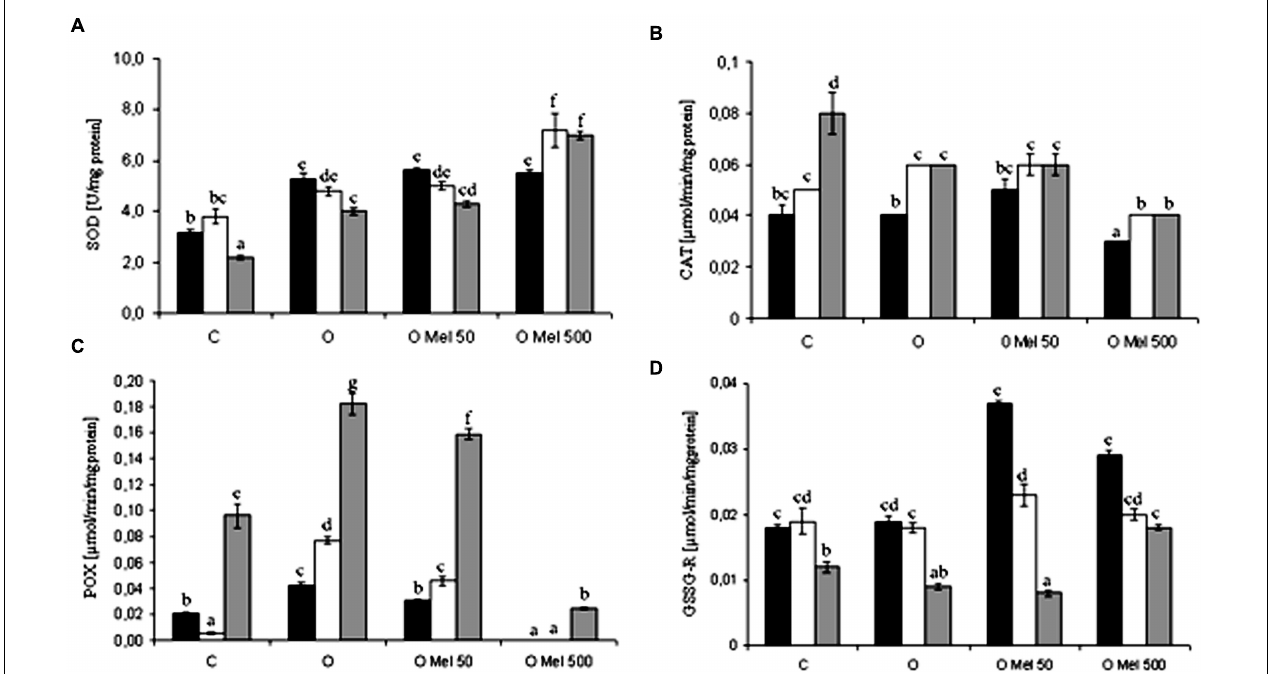
FIGURE 3 | Effect of cucumber seed osmopriming variants on different antioxidant enzymes activity: SOD - superoxide dismutase (A), CAT – catalase (B), POX – peroxidase (C), GSSG-R – glutathione reductase (D) in the axes isolated from seeds: control – untreated (C), osmoprimed without (O) and with melatonin at concentrations: 50 µ M (OMel50) and 500 µ M (OMel500). The seeds were imbibed/germinated in water at 10 ◦ C in darkness for 7 days (CS7 – (cid:3) ), and then subsequently recovered at 25 ◦ C for 2 days (R2 – (cid:4) ). Enzymes activity was also estimated in the axes isolated from the seeds germinated for 24 h in optimal conditions 25 ◦ C (to – (cid:4) ). The results are expressed as mean values of nine measurements ± SEM. Two-way ANOVA and Duncan’s post hoc test were performed. The small letters next to the values show statistical significance p < 0.001. SOD ANOVA results (A) : Variant (C, O, OMel50, OMel500) F (3.60) = 101.4, p < 0.001, Crucial Point (to, CS7, R2) F (2.60) = 10.8, p < 0.001 and interaction Variant × Crucial Point F (6.60) = 9.2, p < 0.001. CAT ANOVA results (B) : Variant (C, O, OMel50, OMel500) F (3.60) = 44.6, p < 0.001, Crucial Point (to, CS7, R2) F (2.60) = 59.2, p < 0.001 and interaction Variant × Crucial Point F (6.60) = 4.4, p < 0.001. POX ANOVA results (C) : Variant (C, O, OMel50, OMel500) F (3.58) = 255, p < 0.001, Crucial Point (to, CS7, R2) F (2.58) = 547.6, p < 0.001 and interaction Variant × Crucial Point F (6.58) = 42.3, p < 0.001. GSSG-R ANOVA results (F) : Variant (C, O, OMel50, OMel500) F (3.57) = 49.4, p < 0.001, Crucial Point (to, CS7, R2) F (2.57) = 238.3, p < 0.001 and interaction Variant × Crucial Point F (6.57) = 38.1, p <